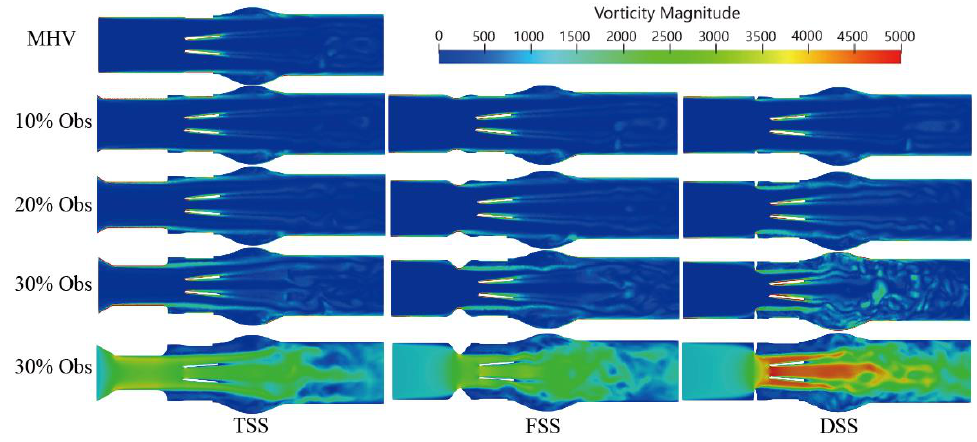
Figure 9. Vorticity distributions downstream without and with SAS at peak time ( t = 0.2 s). Q-criterion can be used to analyze the vortex structures in the flow. The Q-criterion is calculated based on the second invariant of the velocity gradient tensor, which is a measure of the local rate of rotation in the fluid flow. High values of the Q-criterion indi- cate the presence of regions with strong vorticity and can be used to identify the locations of vortices in the flow. In this study, Q-criterion was used to analyze the complex flow patterns and vortical structures. These vortex structures are potentially linked to platelet activation and thrombosis. Velocity gradient , ∇ 𝐮 ∇ 𝐮 = S + Ω , where S is the rate-of- strain tensor, and Ω is the vorticity tensor: